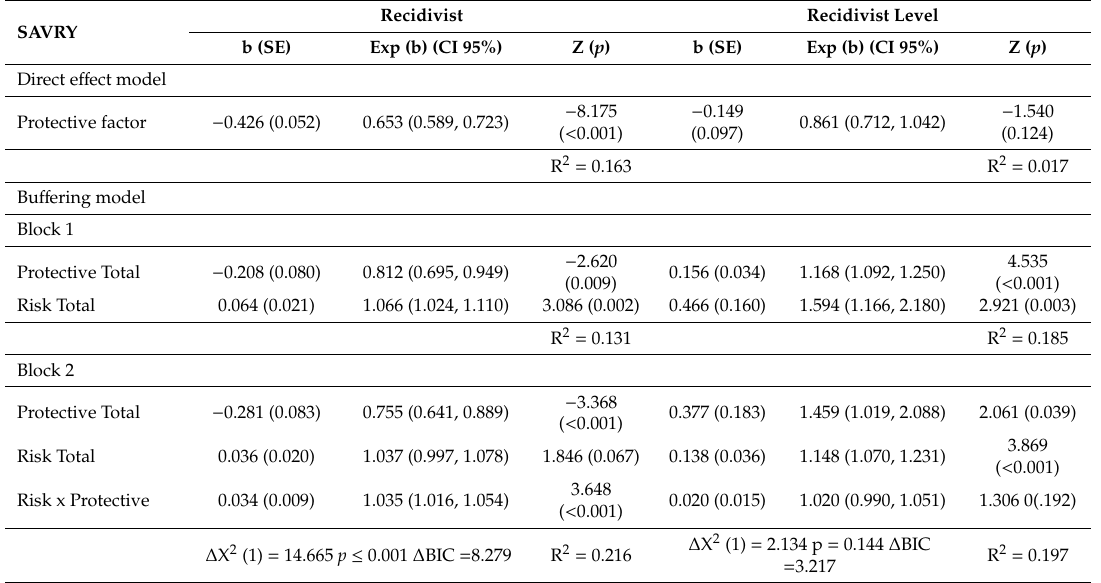
Table 5. Direct vs. bu ff ering e ff ect model (logistic